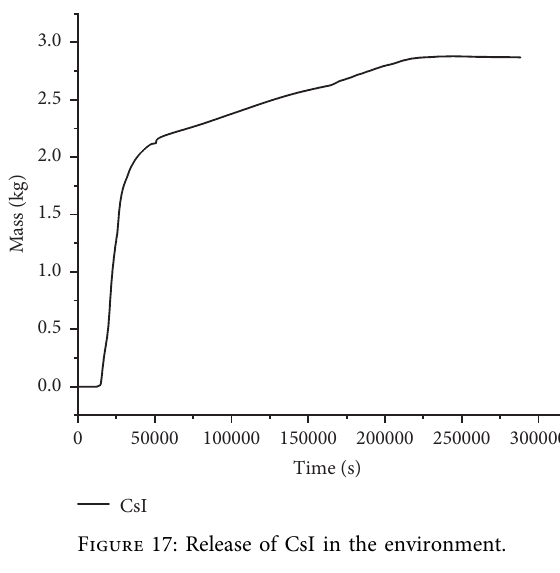
Figure 17: Release of CsI in the environment.